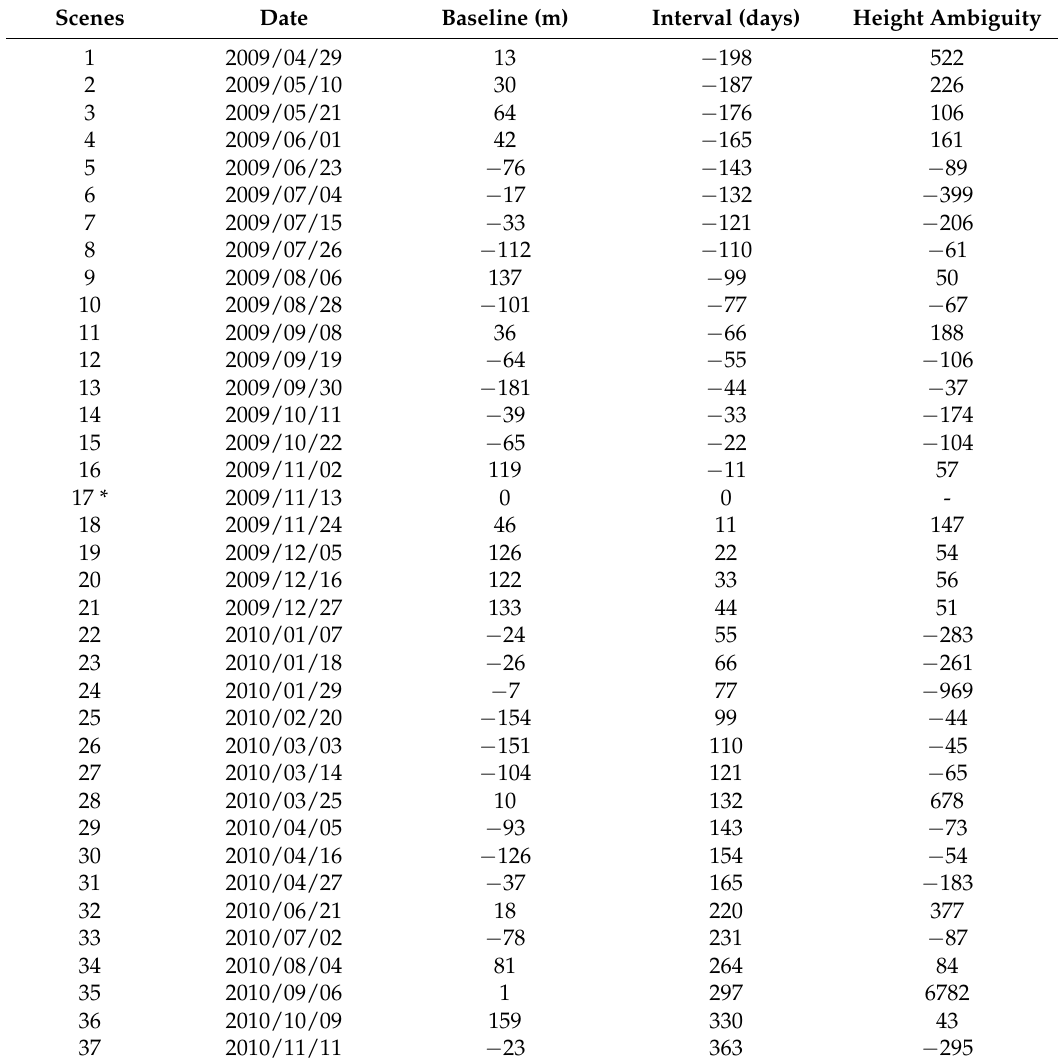
Table 1. TSX Data and Description.